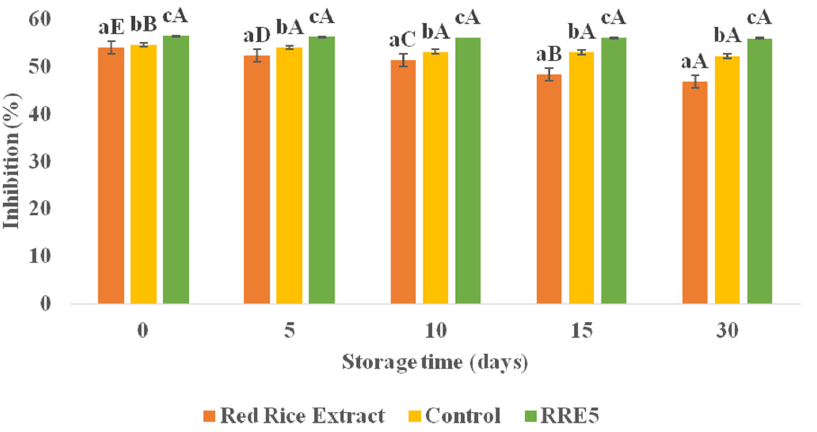
Figure 8. Effect of storage period (30 days) on antioxidant activity of red rice extract, control, and RRE5 nanoemulsion. Data are presented as means ± SD ( n = 3). a–c Means within the column with different lowercase superscripts are significantly different ( p < 0.05) from each other. A–E Means within the column with different uppercase superscripts are significantly different ( p < 0.05) from each